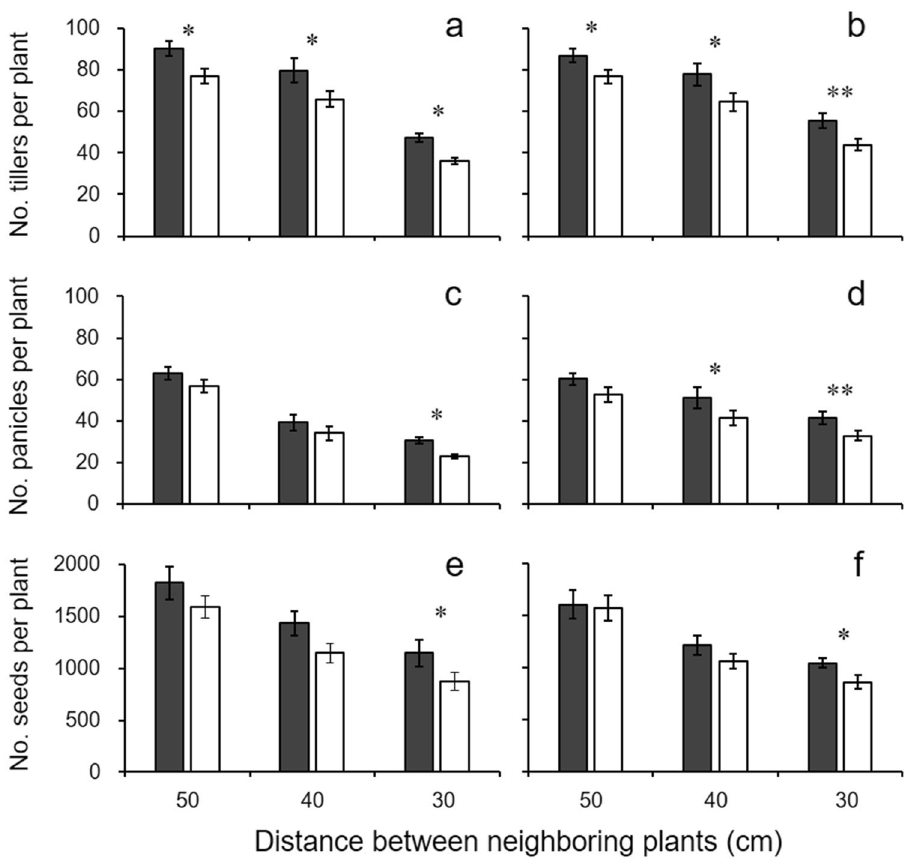
Figure 2. Number of tillers ( a , b ), panicles ( c , d ), and filled seeds ( e , f ) per plant in F 1 transgenic (dark grey columns) and non-transgenic (white columns) crop-wild hybrids derived from WR1 (left panel) and WR2 (right panel), in mixed-planting plots (30 cm, 40 cm, 50 cm plant spacing) with different densities. The comparisons were made between transgenic and non-transgenic F 1 hybrids in mix planting based on paired t -test (N = 6). Bars represent standard error. * or ** indicates significances at the levels of P < 0.05 or P < 0.01,